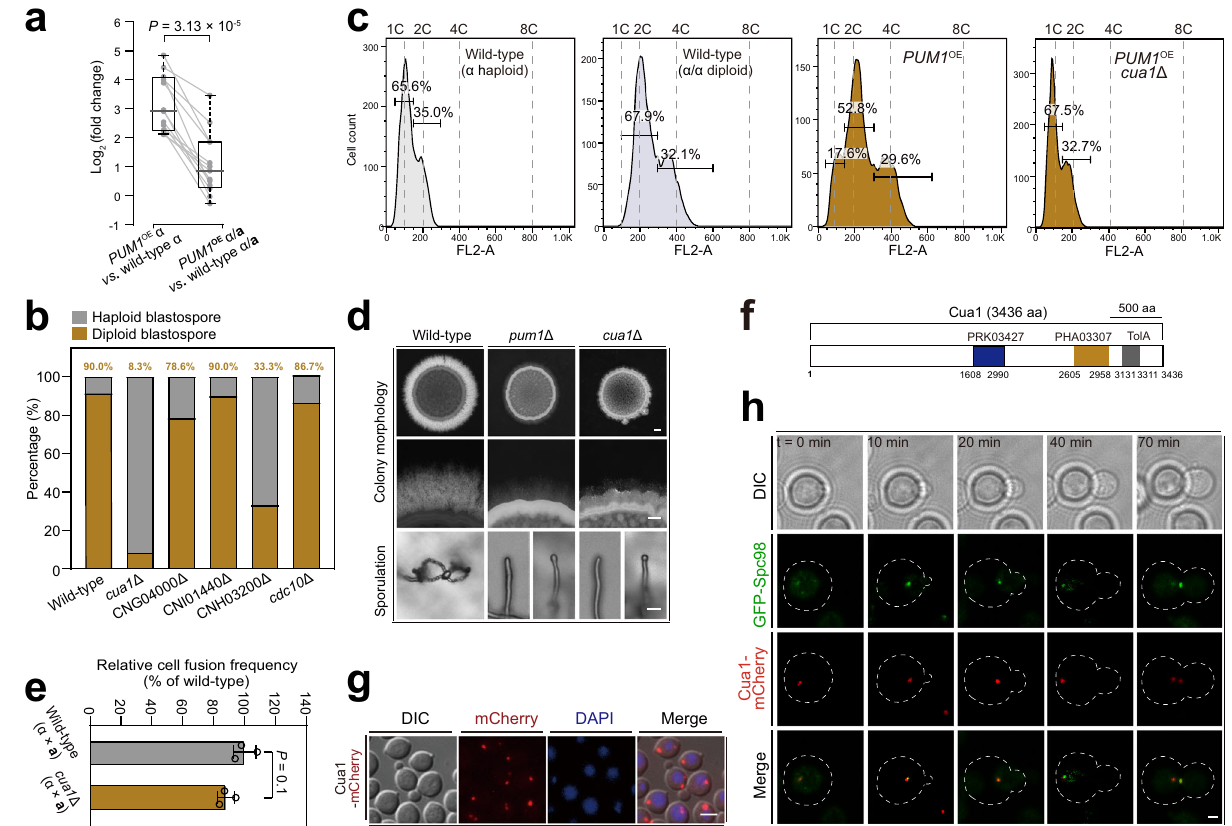
Fig. 7 | CUA1 is essential for Pum1-stimulated ploidy doubling and unisexual reproduction. a Relative mRNAlevelsof the cell cyclegenes in different strains as determined by qRT-PCR. Each dot indicates the mean of fi ve independent experi- ments, two-tailed Student ’ s t test. Boxplots show the median and the upper and lower central quartiles. The expected range of the data is indicated by whiskers. b FACS-based ploidy assessment of blastospores dissected from unisexual hyphae of different strains. For each strain, over 10 blastospores dissected from different unisexual hyphae were tested for ploidy level. The gating strategy is shown in Supplementary Fig. 5d. c FACS-based ploidy level assessment of different strains cultured under sex-suppressing condition. Strains were cultured in YPD liquid medium for 3 days in the presence of BCS, an inducer of the CTR4 promoter (20 μ M),and theploidyof eachstrainwassubsequentlyassessed byFACSanalysis. d The colony morphology, self- fi lamentation and sporulation phenotypes of